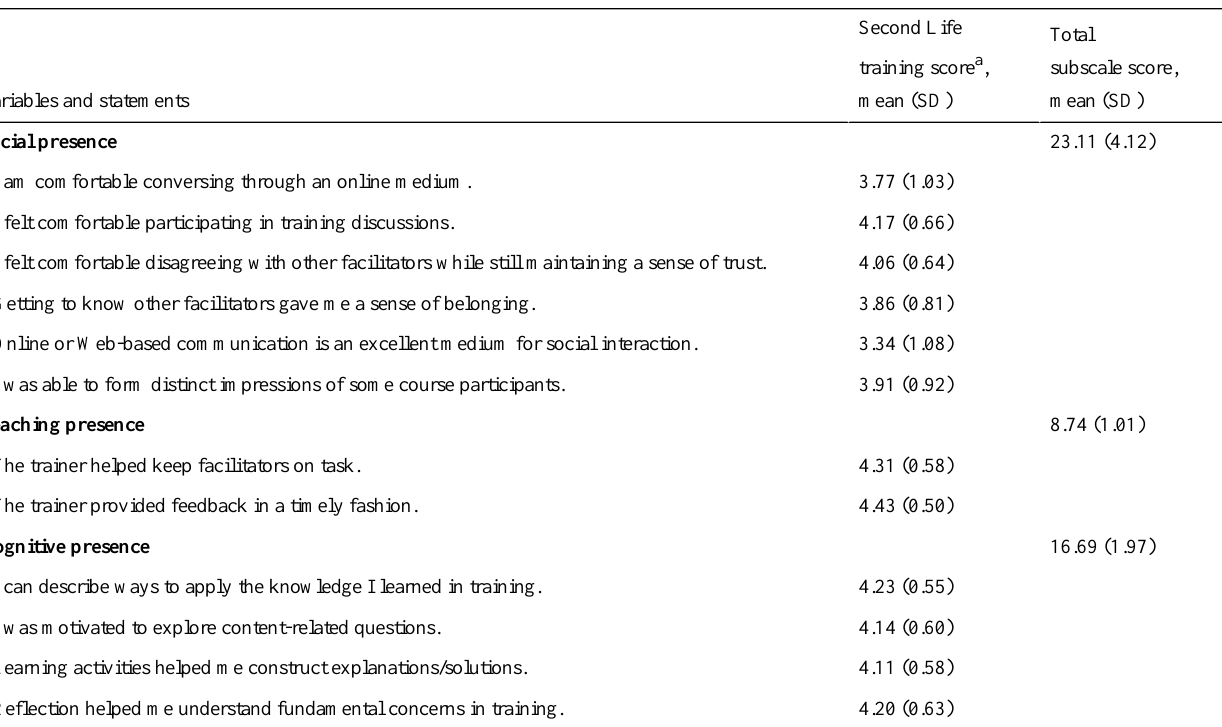
Table 1. Community of inquiry survey statements